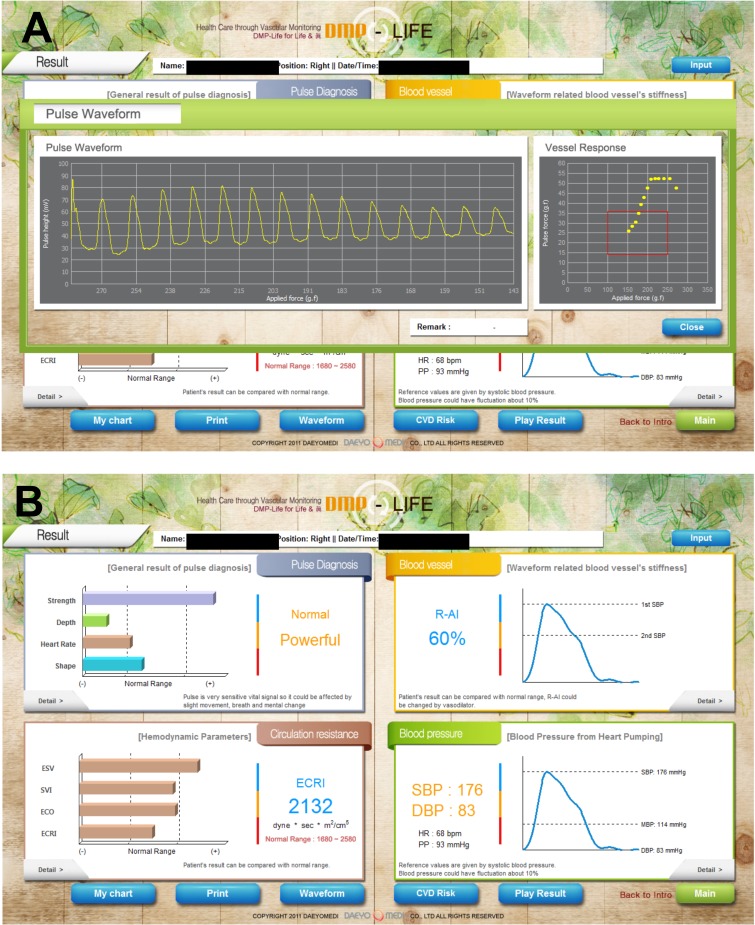
Exemplary demonstration of the results on the DMP-life monitor.(A) When the optimal signal is available, the DMP-life monitor provides a continuous arterial waveform. (B) The DMP-life system’s monitor displays inter alia CO and SV values derived from pulse contour analysis. ESV, estimated stroke Volume (ESV); ESVI, estimated stroke volume index; ECO, estimated cardiac output; ECRI, estimated systemic circulation resistance index; SBP, systolic blood pressure; DBP, diastolic blood pressure.